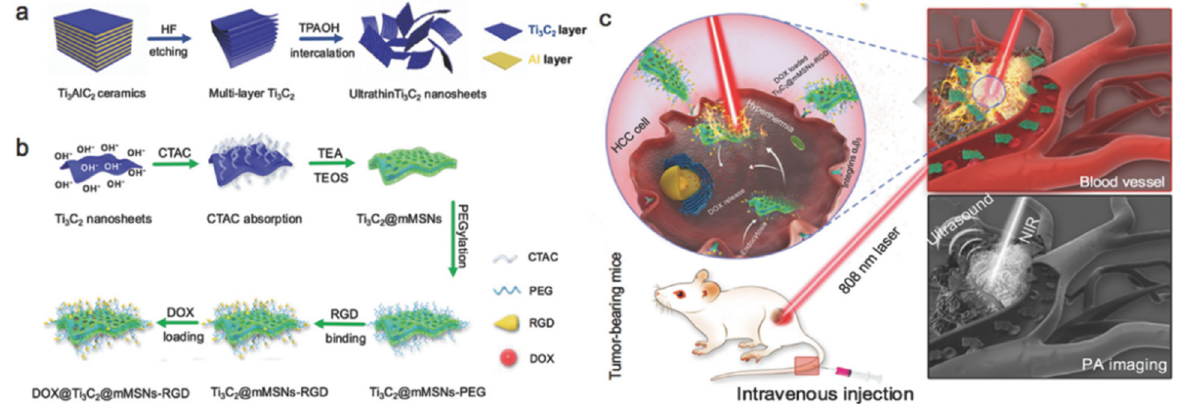
Figure 13. ( a ) Schematic of the fabrication of Ti 3 C 2 @mMSNs-RGD and the synergetic chemo-PTT against HCC with possible PA-imaging guidance and monitoring. ( a ) Schematic of the fabrication of Ti 3 C 2 sheets. ( b ) Schematic of the fabrication of Ti 3 C 2 @mMSNs-RGD. ( c ) Schematic of the theranostic functions of Ti 3 C 2 @mMSNs-RGD. Reproduced with permission from ref. [187] Copyright 2018, Willey.